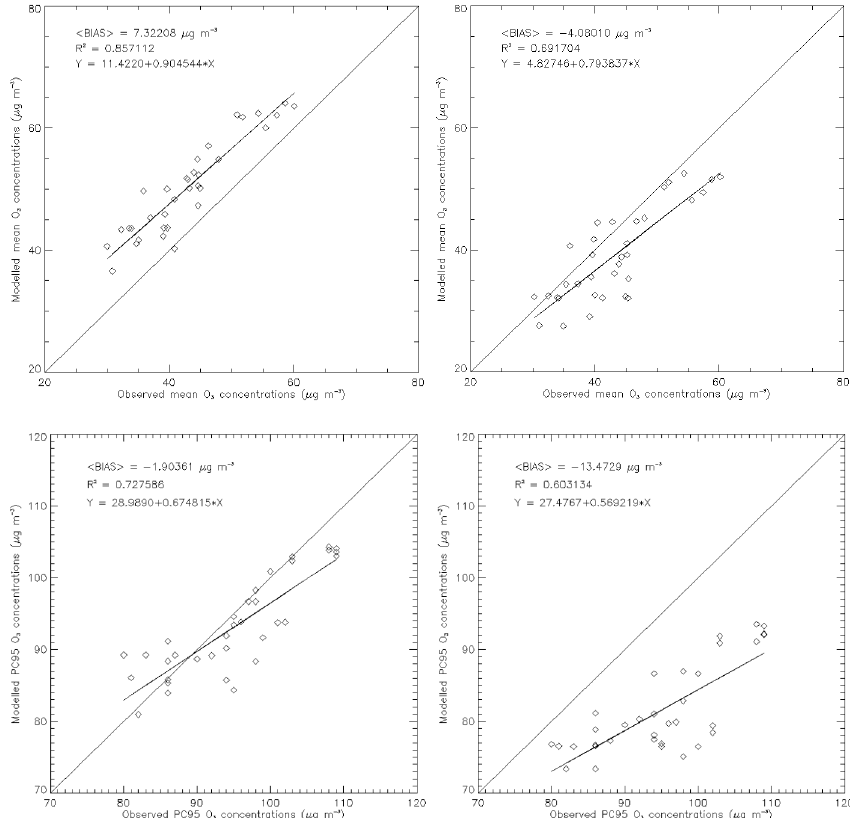
Figure 3. Evaluation of the 10-year (2000–2009) mean and 95th percentile O 3 values for all observation stations. Top left: mean O 3 concen- trations of the 3km simulations. Top right: mean O 3 concentrations of the 25km simulations. Lower left: 95th percentile O 3 values of the 3km simulations. Lower right: 95th percentile O 3 values of the 25km